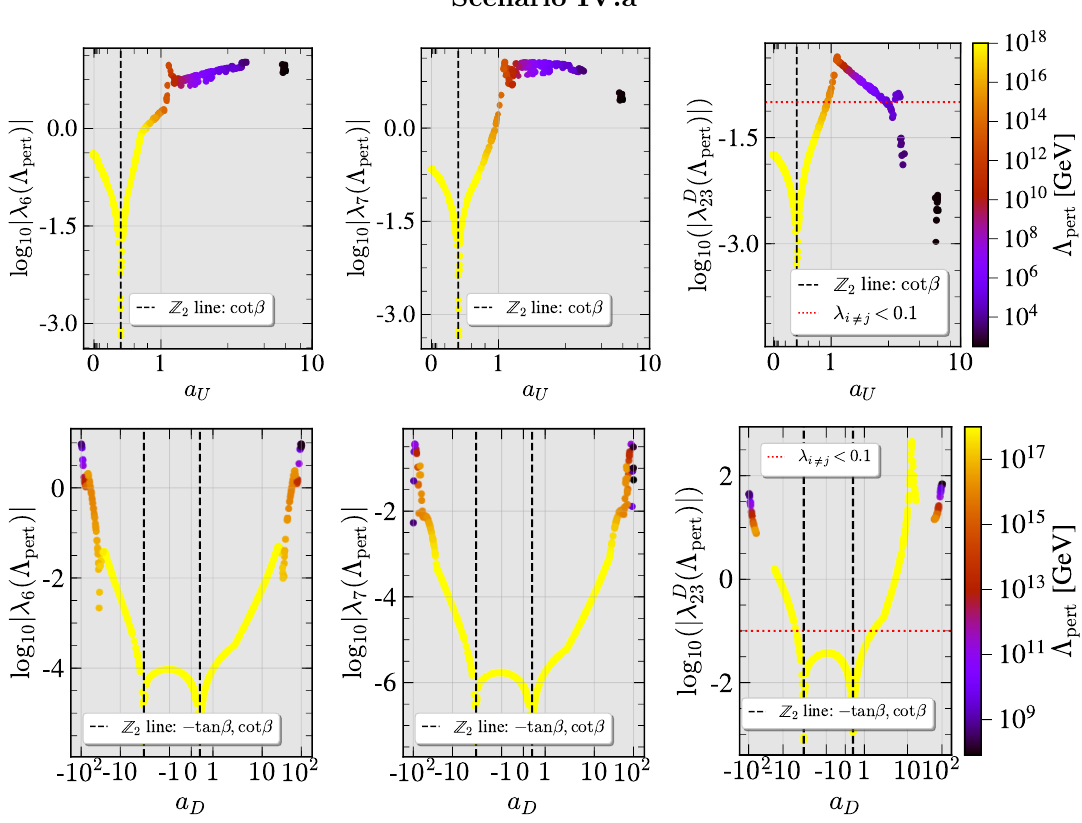
Figure 11 . Separate variation of the alignment parameters a U and a D with the scalar potential in eq. (3.10). a D ( a U ) = cot (cid:12) (cid:25) 0 : 4 in upper (lower)